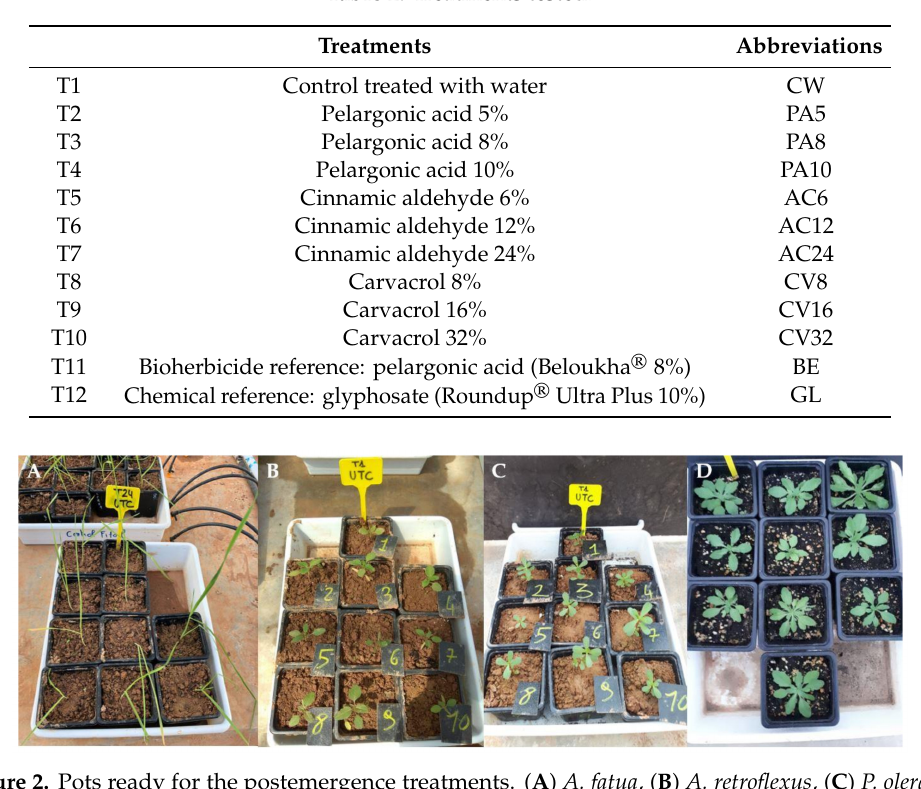
Figure 2. Pots ready for the postemergence treatments. ( A ) A. fatua , ( B ) A. retroflexus , ( C ) P. oleracea , and ( D ) E. bonariensis.